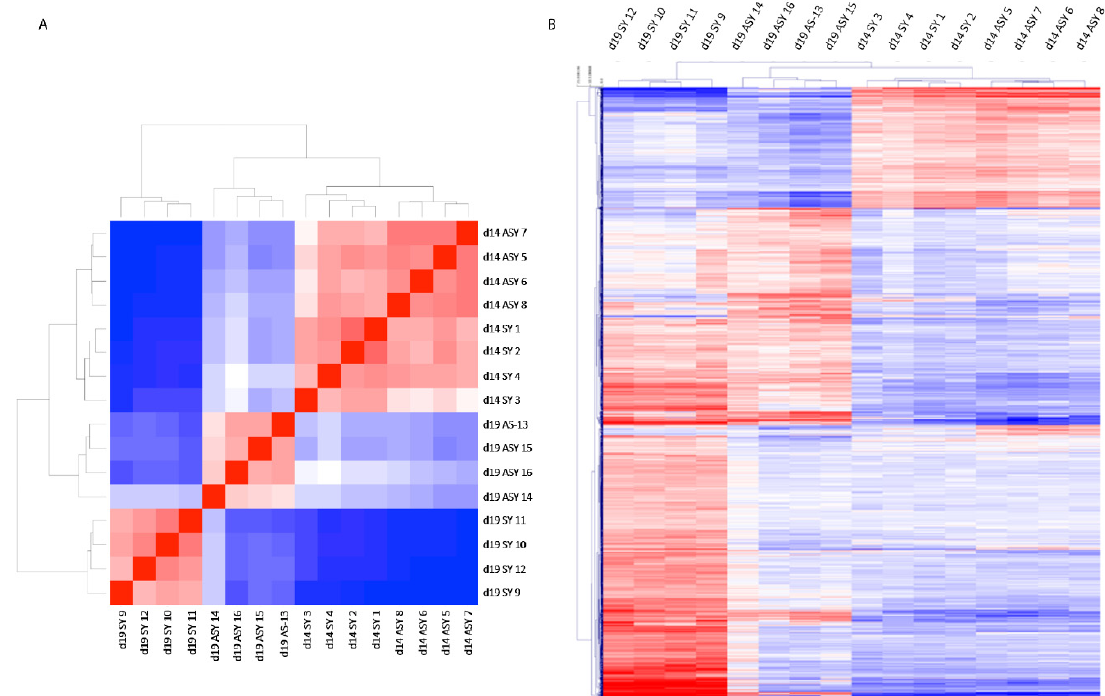
Figure 3. Pair-wise correlation heat map ( A ) and hierarchical cluster ( B ) analysis of DEGs with a log2 fold change higher than 1.4 or lower than -1.4 for equine conceptus membrane samples recovered after transfer of day 8 embryos to a synchronous (day 8: SY) or asynchronous (day 3: ASY) recipient mare, and collected on day 14 (d14) or 19 (d19) of conceptus development (blue = downregulated genes; red = upregulated genes). The sample number is indicated by a number from 1 to 16.